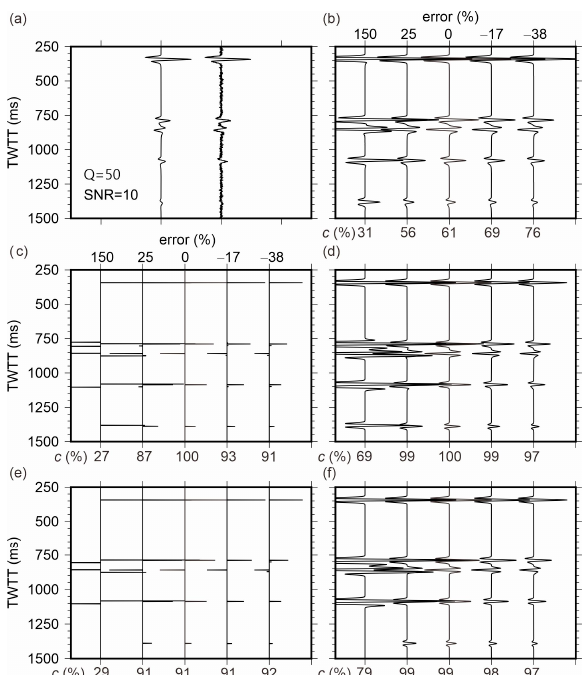
Figure 6. Test for an inaccurate Q used in ITD: ( a ) noise-free and noise-contaminated data with Q = 50 and SNR = 10 dB; ( b ) inverse- Q filtering result using noise-free data; ( c ) reflectivity model inverted by ITD; ( d ) ITD-corrected waveform using noise-free data; ( e ) reflectivity model inverted by ITD with noise-contaminated data; ( f ) the corresponding ITD-corrected waveforms. Trace labels show the relative errors of the Q − 1 used for modeling and inversion.